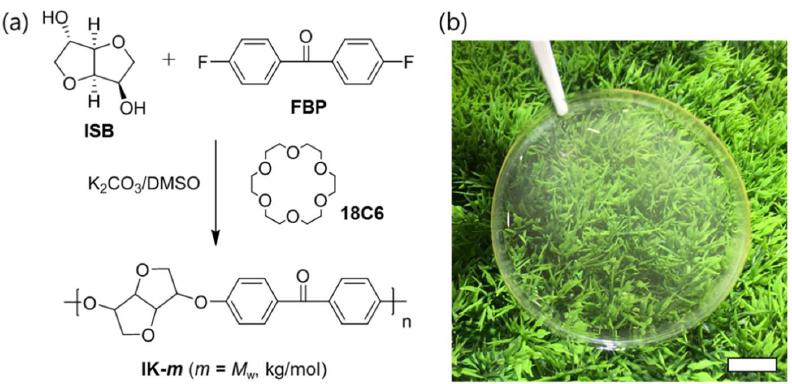
Figure 1. ( a ) Polymerization of ISB-based poly(arylene ether ketone)s of high molecular weight. ( b ) Photograph of IK-110 film (scale bar = 1 cm). Table 1. Polymerization information and results.